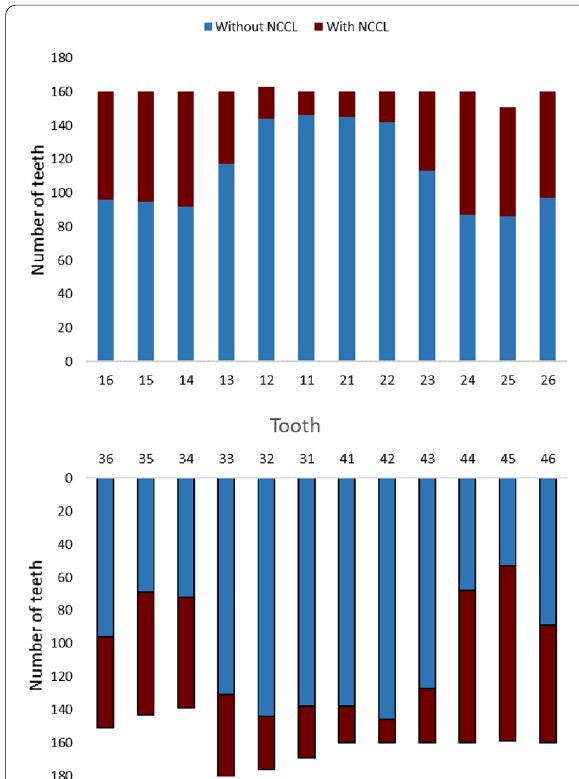
Fig. 1 Prevalence of non-carious cervical lesions in permanent teeth subjected to orthodontic treatment (from first molar to first